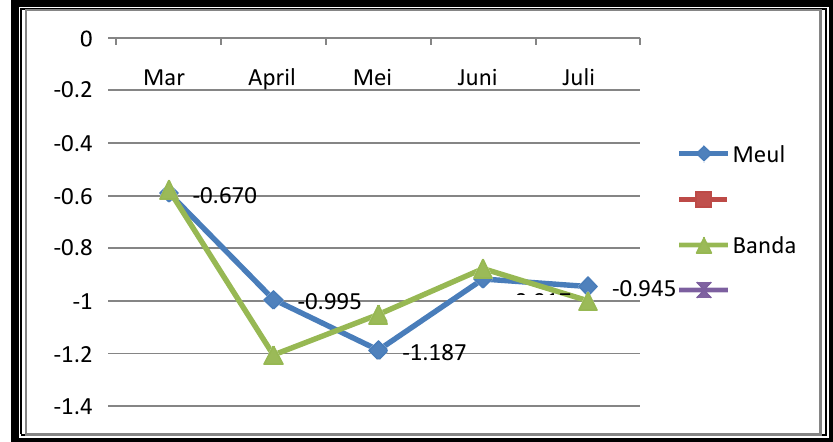
Figure 2 Changes in Demand Price elasticity Tuna: between March and July 2017 Figures 1 and 2 show a shift from rice price elasticity. The elasticity value in Banda Aceh households is higher relative to households Meulaboh. The elasticity is not shown to be significantly in statistical testing both in households Meulaboh and Banda Aceh. This condition is caused by changes in household income is lower than the Meulaboh Banda Aceh households, households Meulaboh more responsive to the increase in food commodity prices. Figure 3 shows the elasticity of tuna. Inflation in March to May has led to a decrease in household welfare in the area of Banda Aceh, and it is higher than households Meulaboh. This is demonstrated by the increase in own-price elasticity becomes elastic. But in May of household wealth in Banda Aceh were changed and it was higher than in households Meulaboh. This is indicated by changes in the price elasticity of the goods themselves. In June the value of goods own price elasticity decreased both in the area of Meulaboh and Banda Aceh. Lowest inflation emerged during the study period and it makes household welfare for the better. In July 2017, an increase in inflation of food commodities led to a decrease in household welfare Banda Aceh and Meulaboh. The elasticity in Banda Aceh households is higher than households